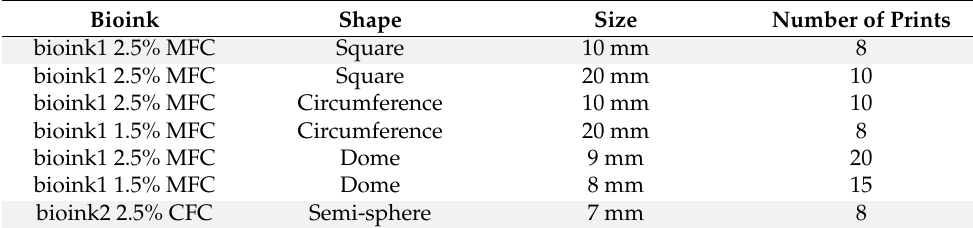
Table 3. Shapes printed, sizes and number of prints.